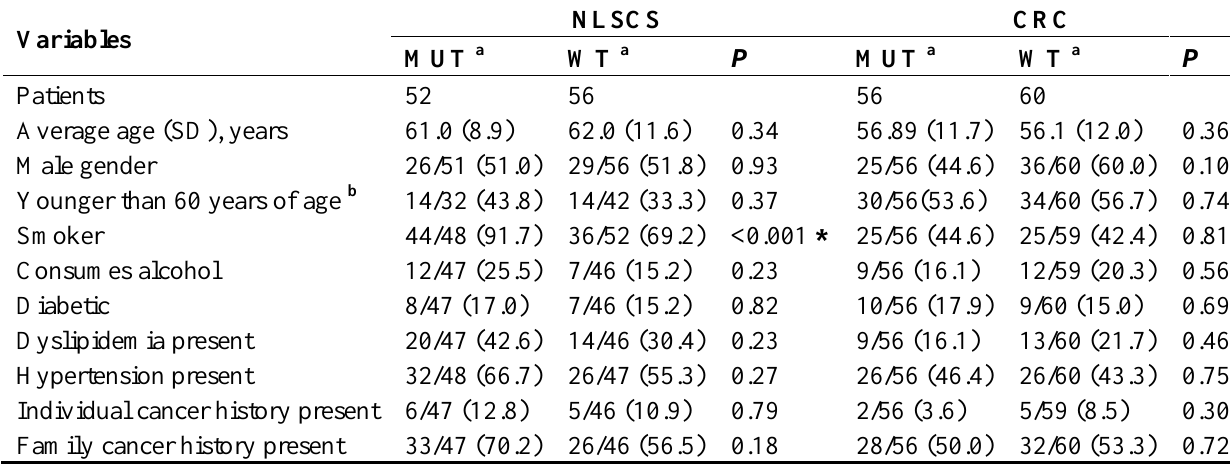
Table 1. Clinical and metabolic parameters of the 108 non-small cell lung cancer (NSCLC) and 116 colorectal cancer (CRC) patients screened for KRAS mutations.